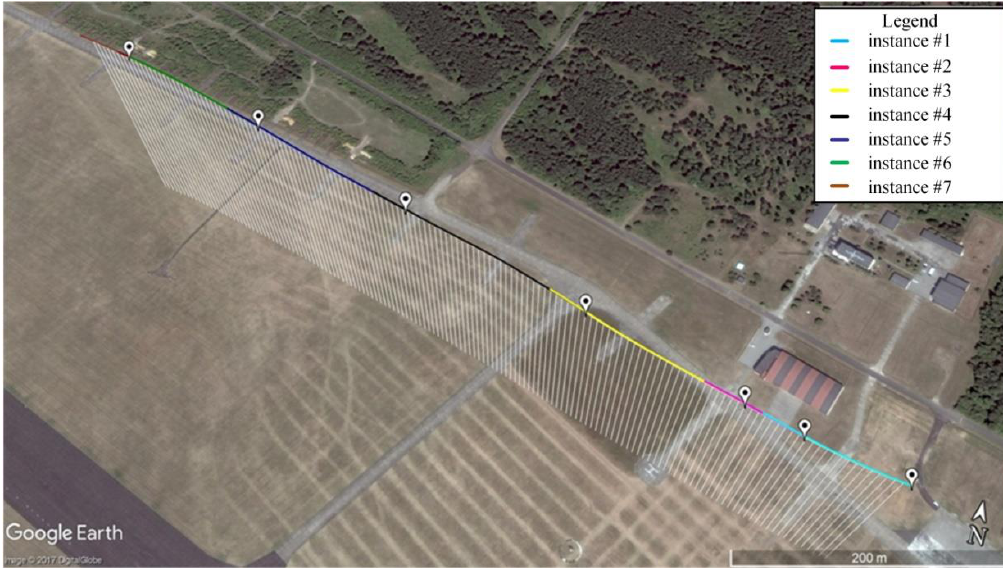
Figure 5. MINS trajectories for flight no 1.